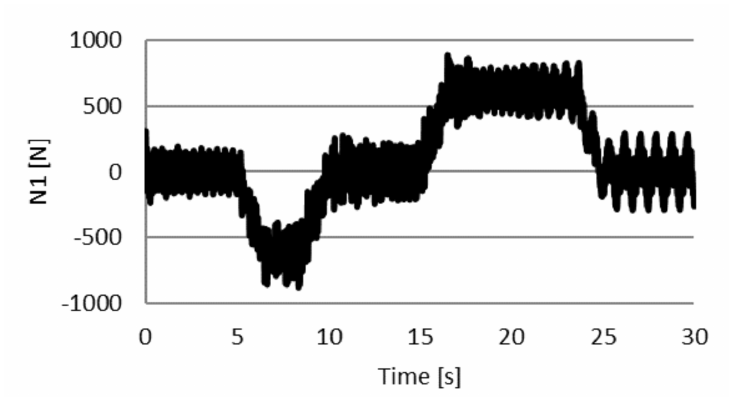
Figure 15. Change in the wheels’ pressure on the road surface on the front axle with control by criterial function K ( 1 ) .